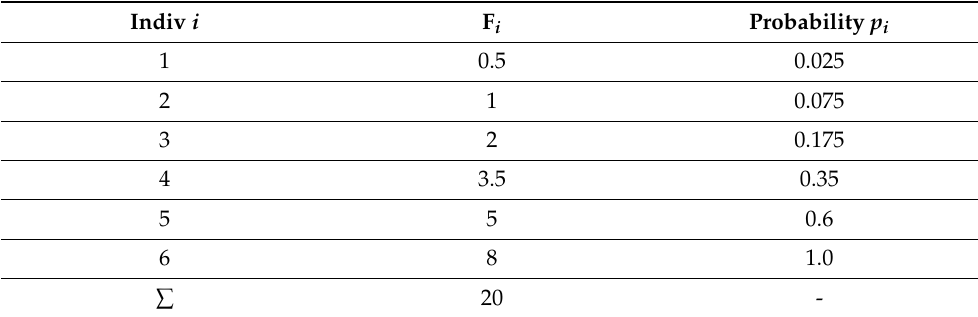
Table 2. Obtaining selection probabilities for a population of six individuals using the roulette technique, with the objective of maximizing the fitness